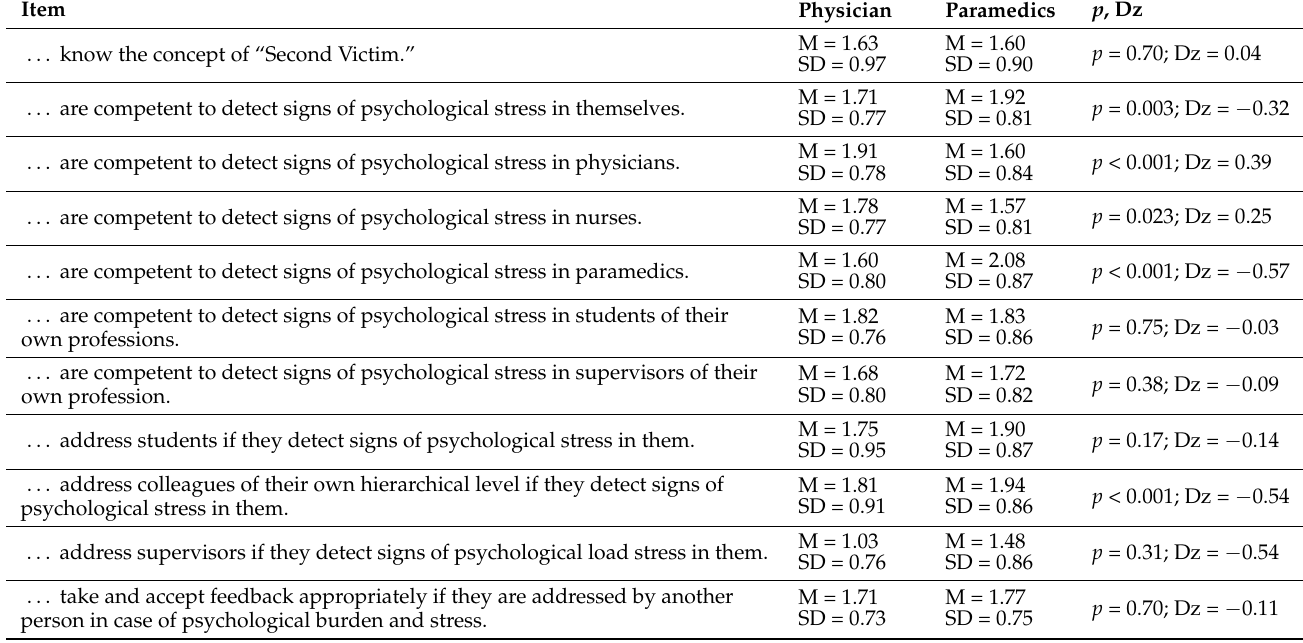
Table 3. Results of paired samples t-tests with bootstrapping (bias-corrected and accelerated (BCa) based on 1000 samples) of differences between the assessment of physicians’ and paramedics’ compe- tencies estimated by physicians. Dz shows effect Size according to Cohen’s